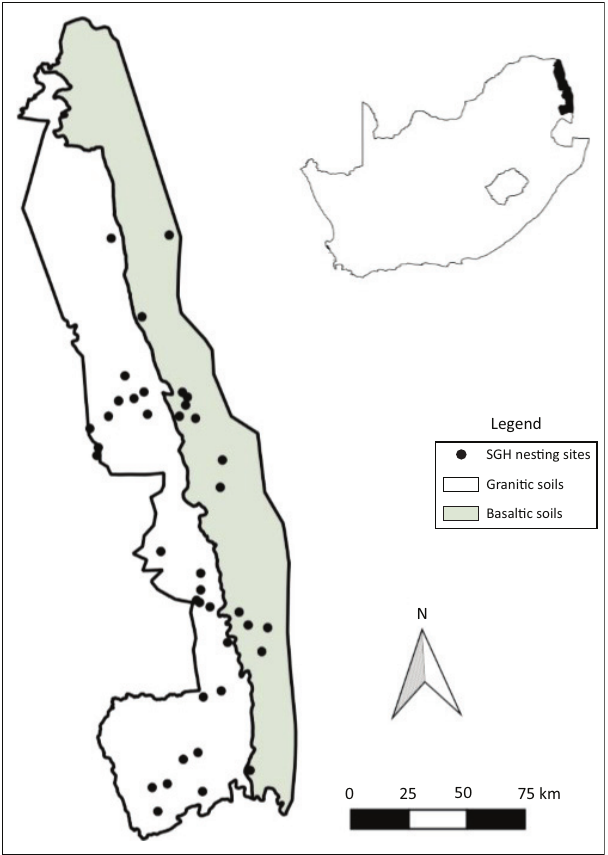
FIGURE 1: The locations of Southern Ground-hornbill nesting sites within the Kruger National Park, South